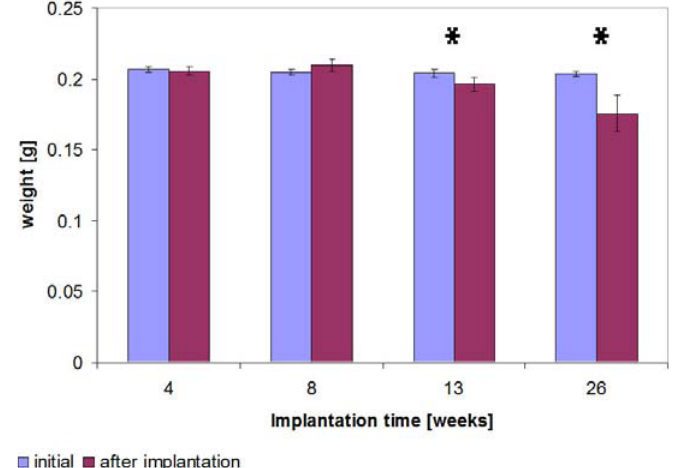
Figure 10. Implants’ weight measurements following hydrofluoric acid treatment for the different implantation times 4, 8, 13 and 26 weeks, significant weight reductions (p ≤ 0.05) in comparison to the initial values are verifiable from the 13th week and are identified by *.